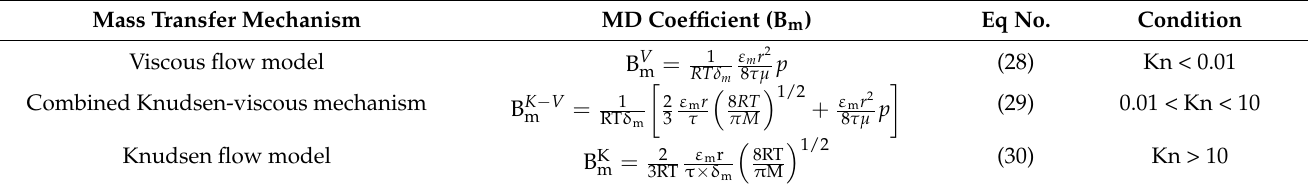
Table 2. Estimation of membrane distillation coefficient (Bm) in VMD